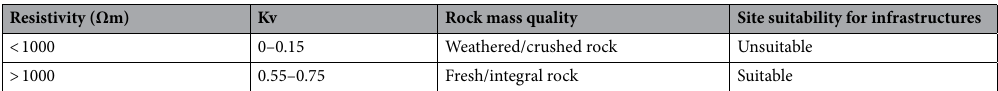
Table 1. Correlation between ERT and well data using the specific values range of resistivity and Kv for rock mass quality evaluation.